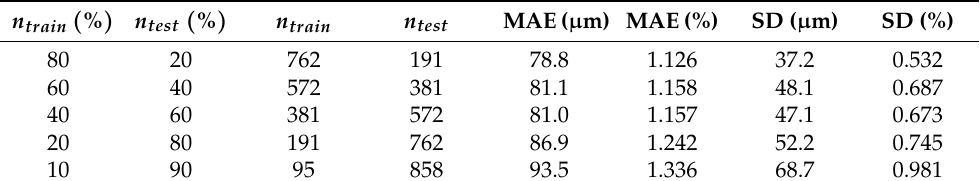
Table 6. Mean MAE of the 3D reconstruction algorithm SDU-Net with reduced number of training data. Different proportions of the data were used in the training part. In addition of the MAE, its standard deviation (SD) was calculated to indicate the dispersion in the test samples. The table shows the averaged values of 20 random train–test splits each.